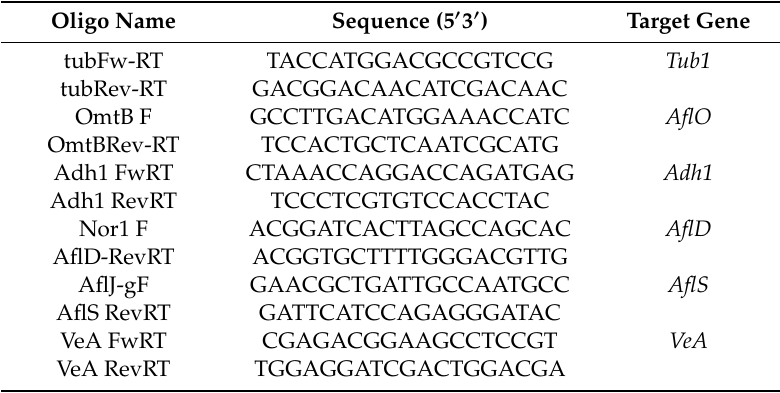
Table 1. Oligonucleotides sequence and target genes used in this study. Oligo Name Sequence (5 (cid:48) 3 (cid:48) )